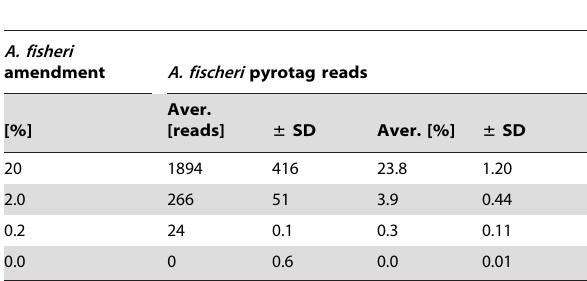
Figure S1 Reproducibility of pyrotag read abundance across technical replicates of one aquifer sediment DNA extract. Results from a representative extract (replicate c, 2006) are shown only for the most abundant phyla as detailed in Figure 1. (TIF) Figure S2 Quantitative recovery and reproducibility of pyrotag read abundance for selected dominating taxa in spiking experiment. Sediment DNA was spiked with defined amendments (20, 2, 0.2 and 0%) of Aliivibrio fisheri rRNA genes. Two series (0–20%) of amended sediment DNA (extract c, 2006) were analysed in technical duplicates via one-step PCR (A), and one series of amendments via two-step PCR (B). Table S1 Number of reads and average read lengths for pyrotag libraries of natural aquifer sediments. Table S2 Number of reads and average read lengths for pyrotag libraries from spiking experiment.